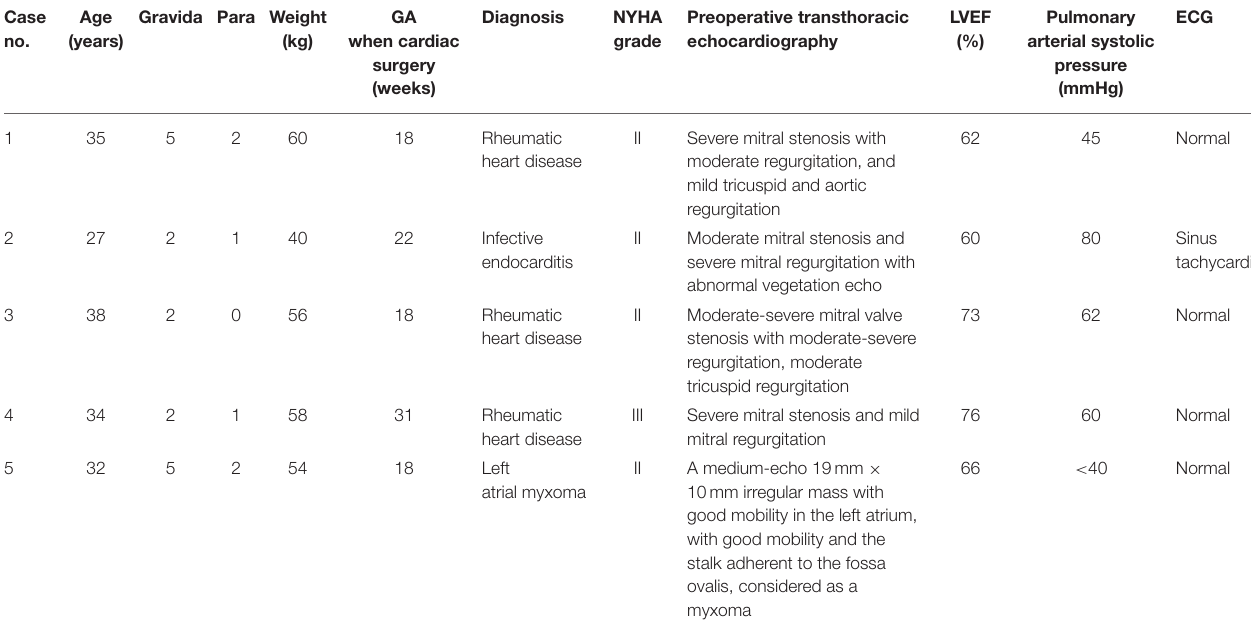
TABLE 1 | Baseline characteristics of five patients undergoing minimally invasive cardiac surgery (MICS) during pregnancy. Case